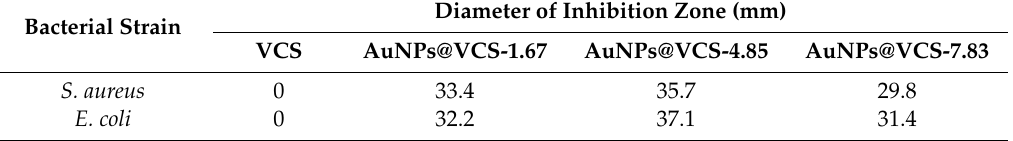
Figure 9. Inhibition zones of the VCS and different AuNPs@VCS against S. aureus ( a – d ) and E. coli ( e – h ) after incubation for 24 h. The diameter of sponge samples is 14 mm. Table 1. Inhibition zone diameters (mm) of sponge samples against S. aureus and E. coli after incubation for 24 h.